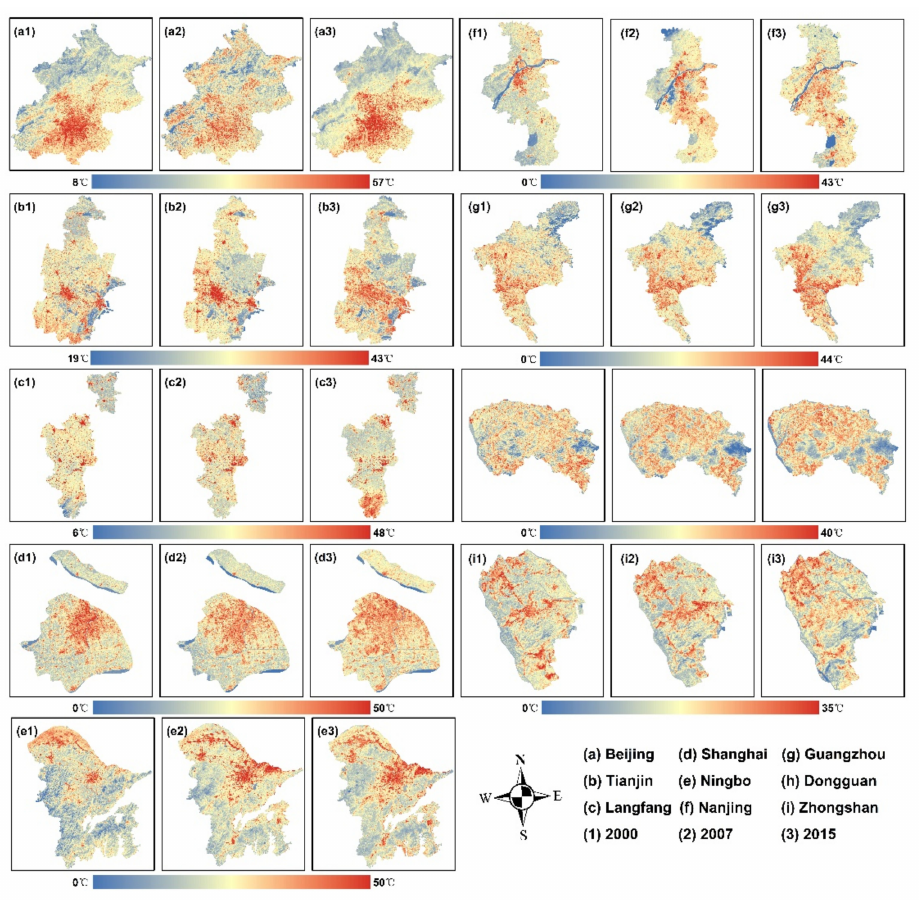
Figure 3. Spatiotemporal changes of the LST during 2000–2015 across cities. Code scheme 1, 2, and 3 denotes 2000, 2007 and 2015 respectively, e.g., e1 denotes LST changes across Ningbo during